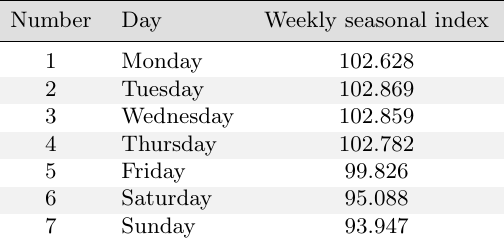
Table 1: DPD demand indices.